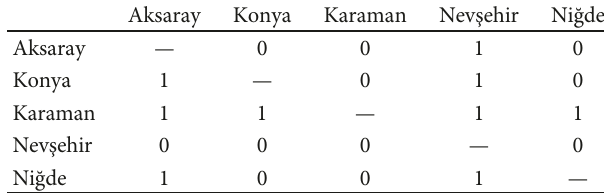
Table 7: Matrix E .